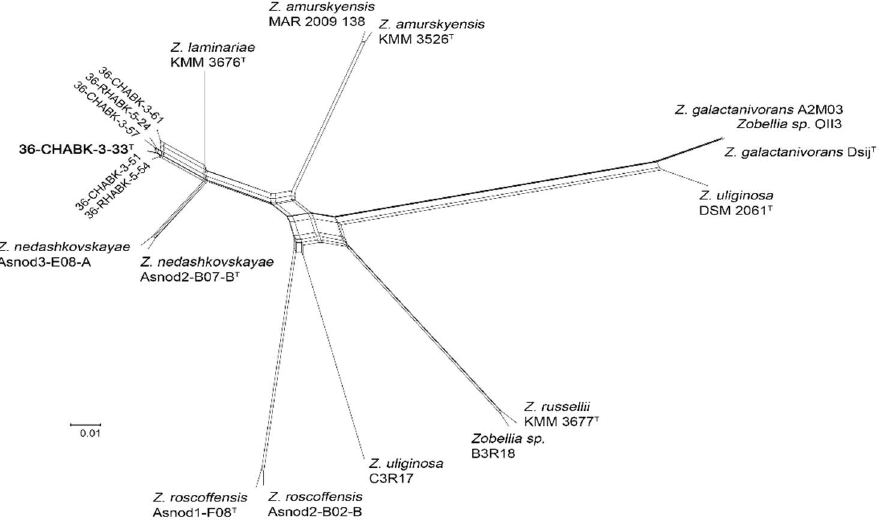
Figure 2. Split network tree of Zobellia strains based on concatenated partial dnaK - gyrB - pyrH - recA - topA (2570 bp) gene sequences by SplitsTree4 program [16].